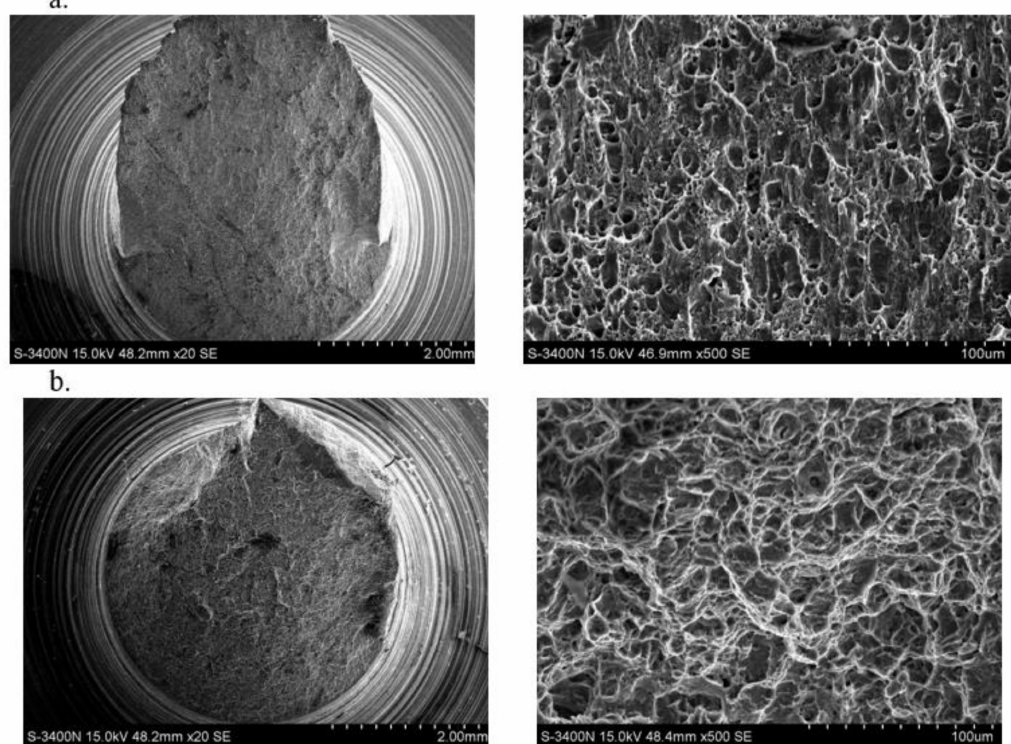
Figure 13. Specimen fractures after dynamic tension with the linear rate of the impact hammer v = 30 m/s for: ( a ) PA4; ( b )